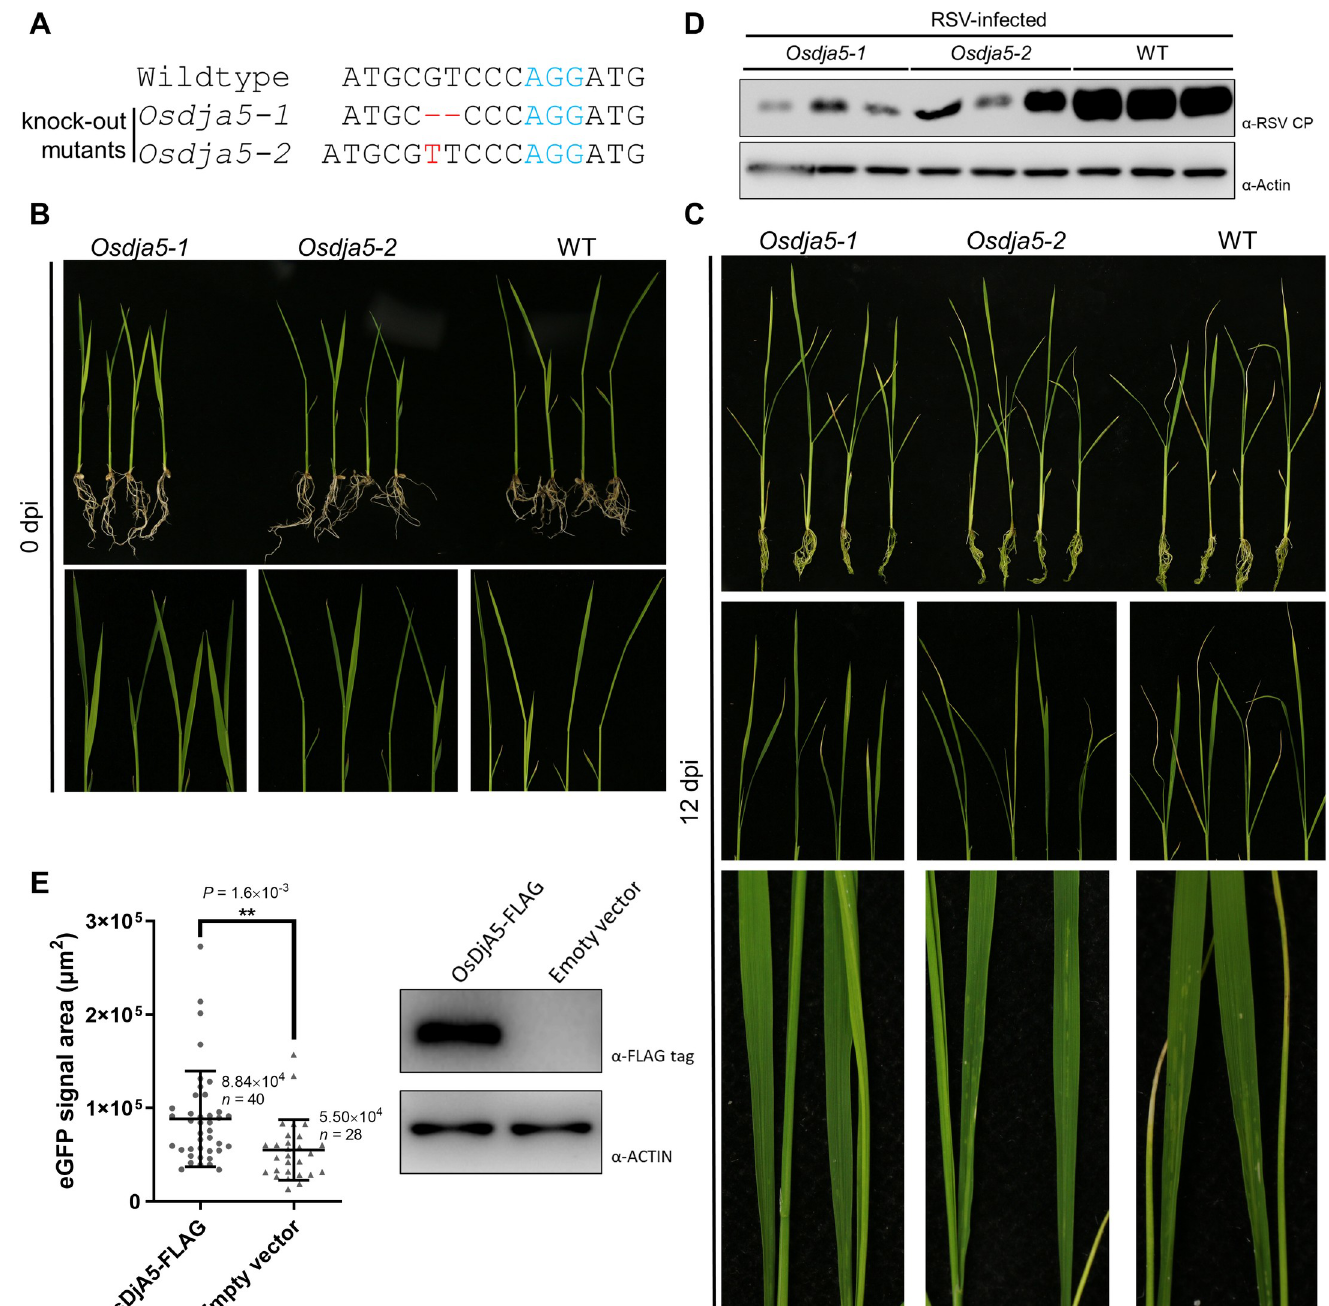
Fig 6. Challenge rice Osdja5 knock-out mutants with RSV. (A) Diagram of frameshift mutations in Osdja5-1 and Osdja5-2 . The blue bases represent the PAM sequence, and red bases mark mutation sites. (B) The phenotype of Osdja5 knock-out mutants. (C and D) The symptom (C) and virus accumulation levels (D) of Osdja5 mutants and wild type plants infected by RSV at 12 dpi. The virus accumulation levels were detected by western blotting using a monoclonal antibody against RSV CP and Actin was used as a loading control here. (E) Analysis of the effects of OsDjA5 to the NSvc4 rescued cell-to-cell movement of PVX( Δ p25)-eGFP. Agrobacterium carrying OsDjA5- FLAG or empty vector was mixed with agrobacteria carrying 800-fold-diluted PVX( Δ p25)-eGFP, NSvc4, and TBSV p19. Each mixture was infiltrated into each half of the same leaf. The leaves were observed under fluorescence stereoscopic microscopy at 5 dpi. The area of eGFP fluorescence was measured by ZEN lite software and analyzed by student’s t -test (two-sided, �� P < 0.01); the mean and the number of measured area ( n ) were labeled. Western blotting confirmed the expression of OsDjA5-FLAG.